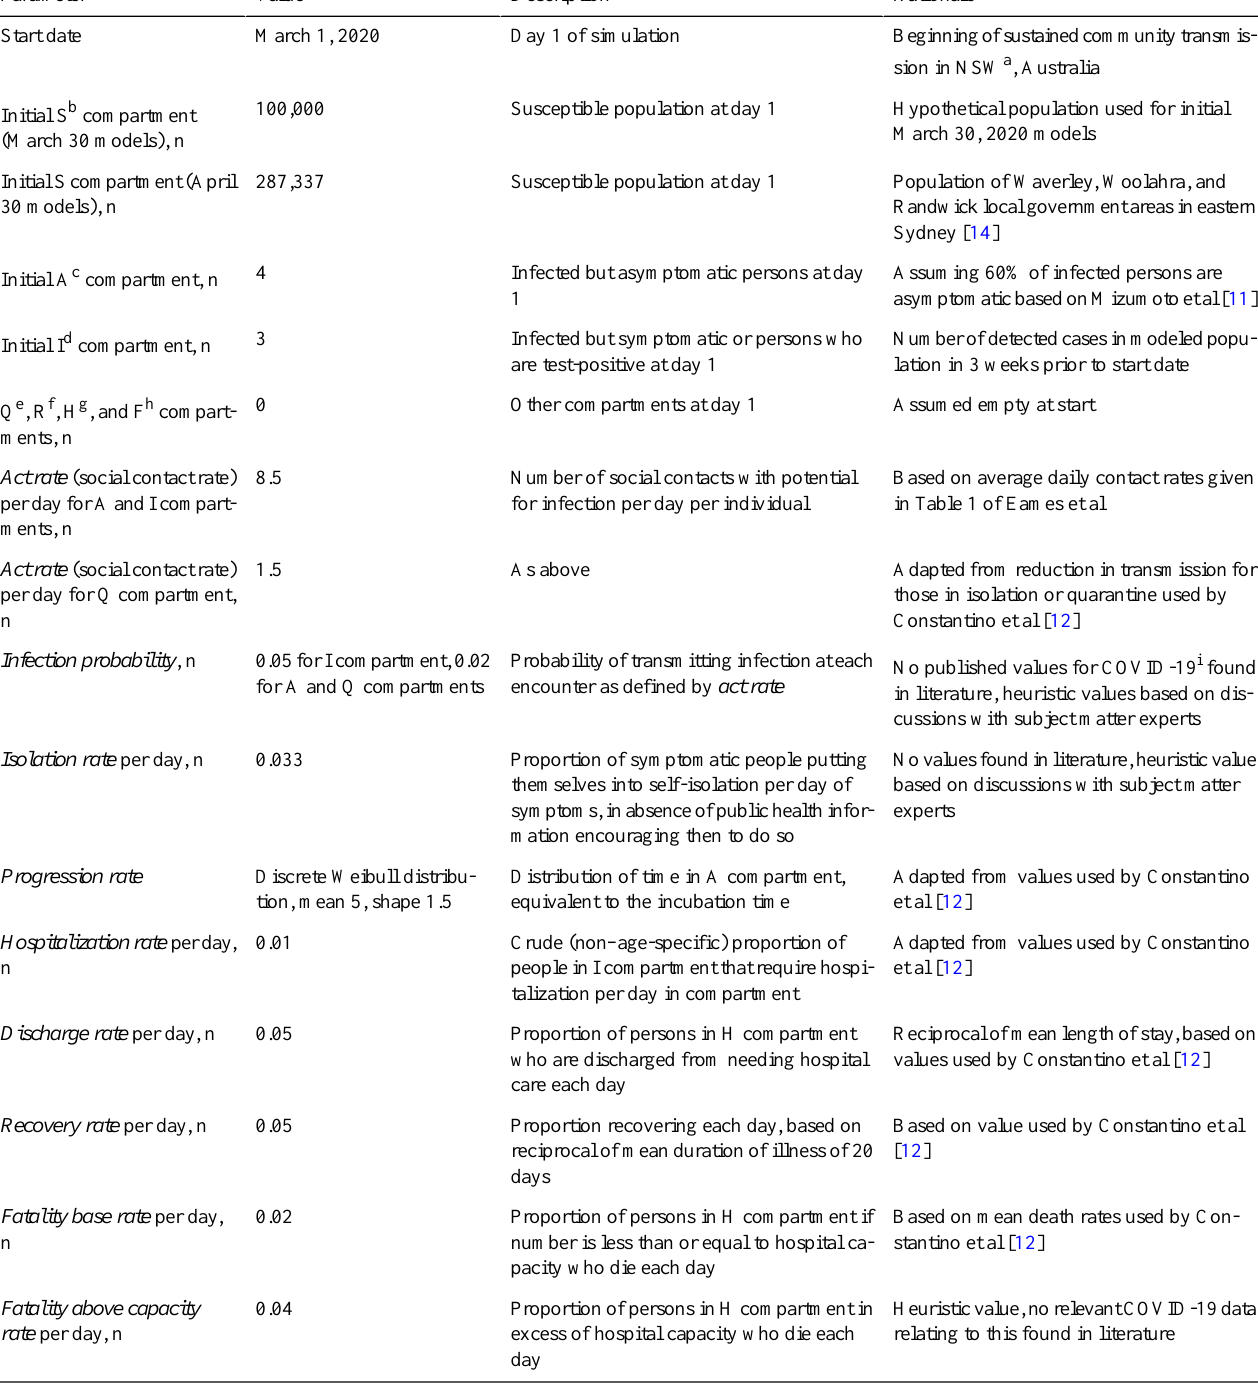
Table 1. Parameters used for baseline